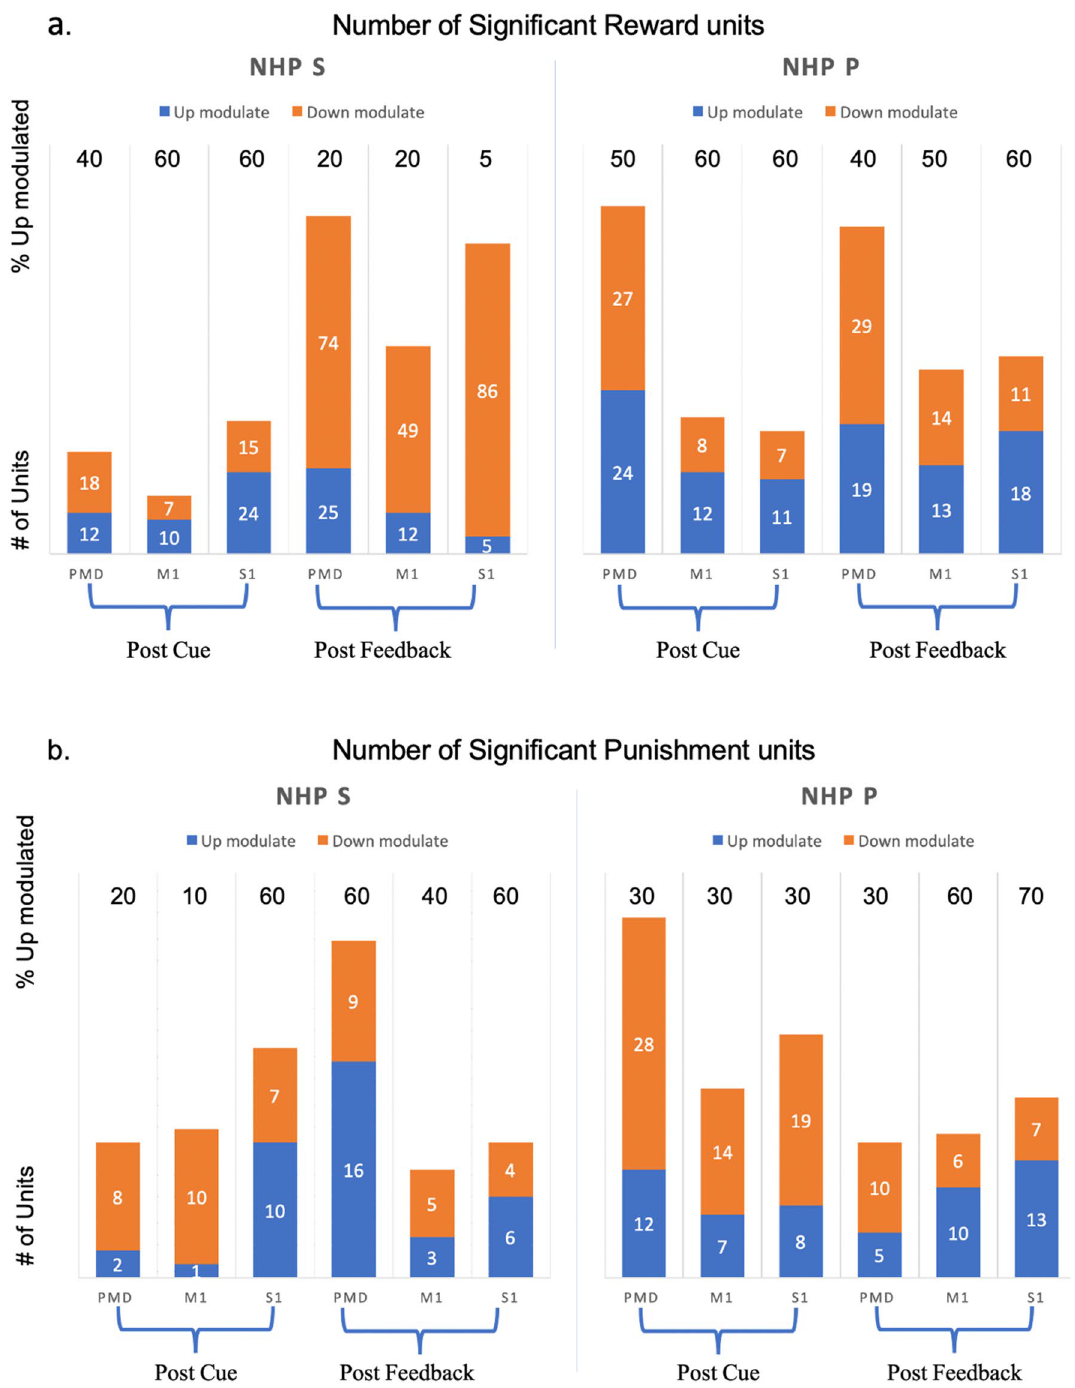
Figure 8. Modulation (up or down) for units with significant divisive normalization from two NHPs for three sensorimotor brain regions. ( a ) shows population analysis for reward modulation. ( b ) shows punishment modulation. Orange bars indicate the number of units with down-modulation, while the blue bars show the number of units with up modulation. Numbers at the top of each column are the percentage of units with up